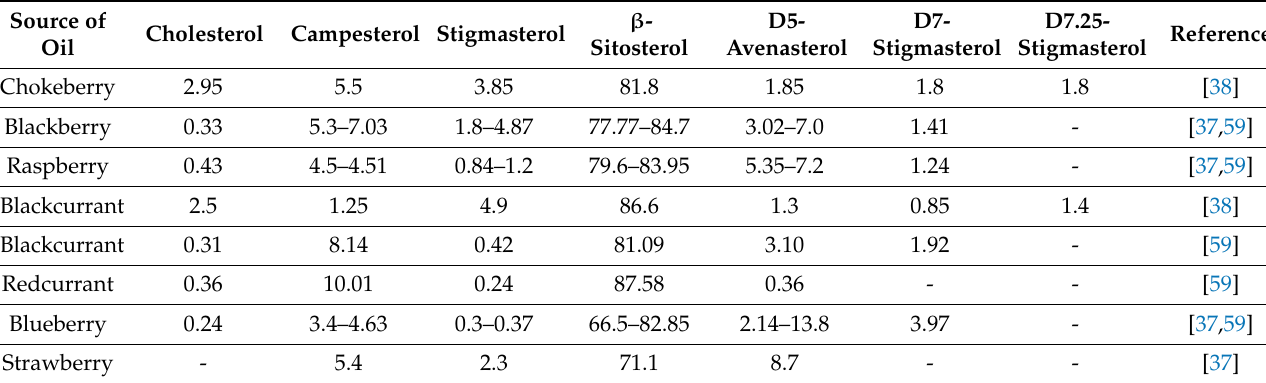
Table 3. Sterol composition of lipid fraction of berry pomaces (%).